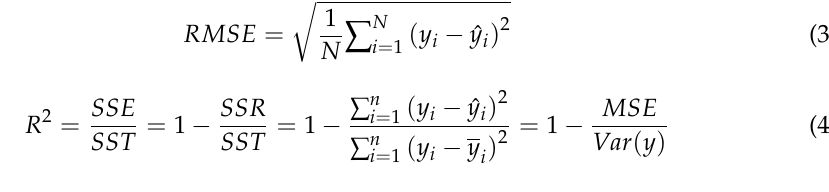
Table 6. Result of each model prediction for abnormal cells.